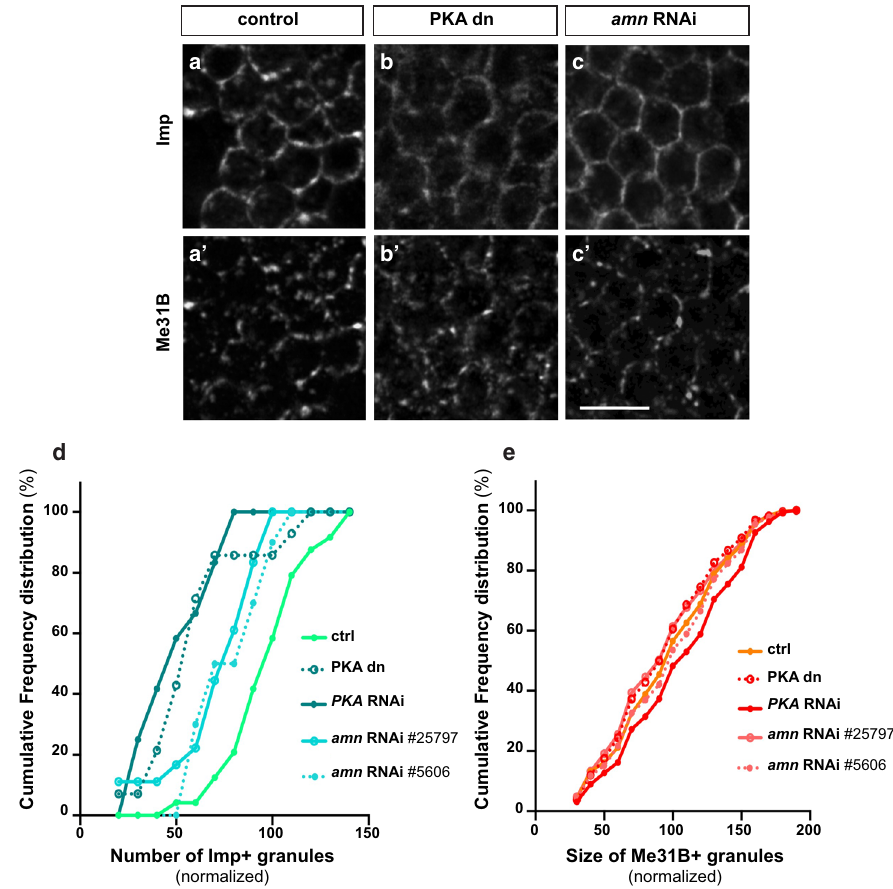
Fig. 6 Inactivating PKA inhibits the recruitment of Imp to RNP granules in aged fl ies. a – c Cell bodies of MB γ neurons imaged from 30 day-old (aged) control brains ( a ), brains expressing a kinase dead PKA catalytic subunit ( b ), or brains expressing amn RNAi ( c ). PKA dn stands for PKA dominant negative. Scale bar: 5 μ m. d Numbers of Imp + granules (per surface area) in MB γ neurons of 30 day-old control brains (light green) or brains with reduced